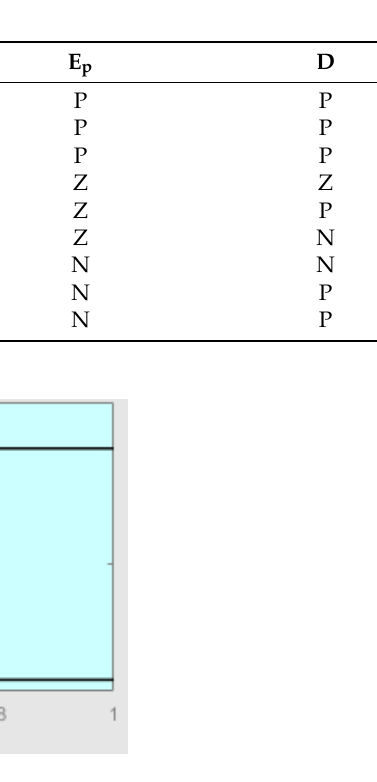
Figure 7. Output of the linguistic variable D(k).